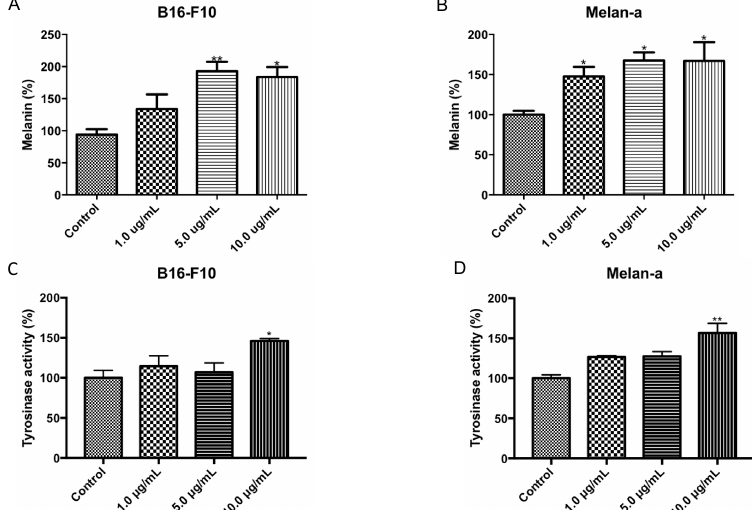
Figure 6. CMS ‐ 2 activates melanogenesis in melanoma and melanocyte cell line. Cell melanogenesis was evaluated by measuring the amount of melanin and tyrosinase activity after 24 h of CMS ‐ 2 treatment (1–10 μ g/mL): melanin content in B16 ‐ F10 ( A ) and Melan ‐ a ( B ); and tyrosinase activity in B16 ‐ F10 ( C ) and Melan ‐ a ( D ). * p < 0.05 and ** p < 0.01, analysis of variance, Newman–Keuls post ‐ test.